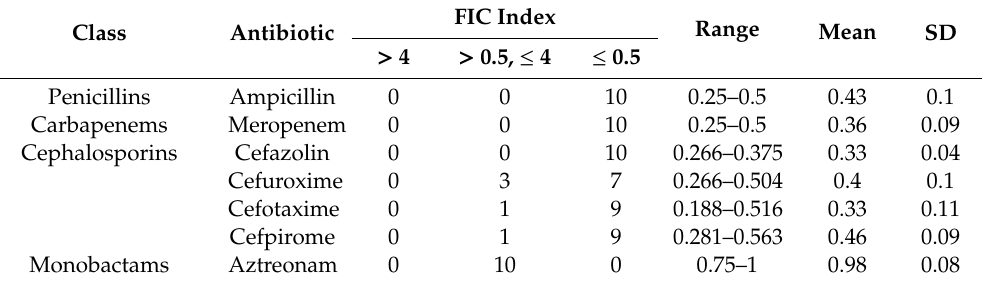
Table 2. The checkerboard microdilution assay of seven antimicrobial agents combined with a crude extract of Pongamia pinnata seed coat against 10 methicillin-resistant Staphylococcus aureus isolates. The initial concentration of each bacterial suspension was 1.5 × 10 5 CFU mg mL − 1 . The final